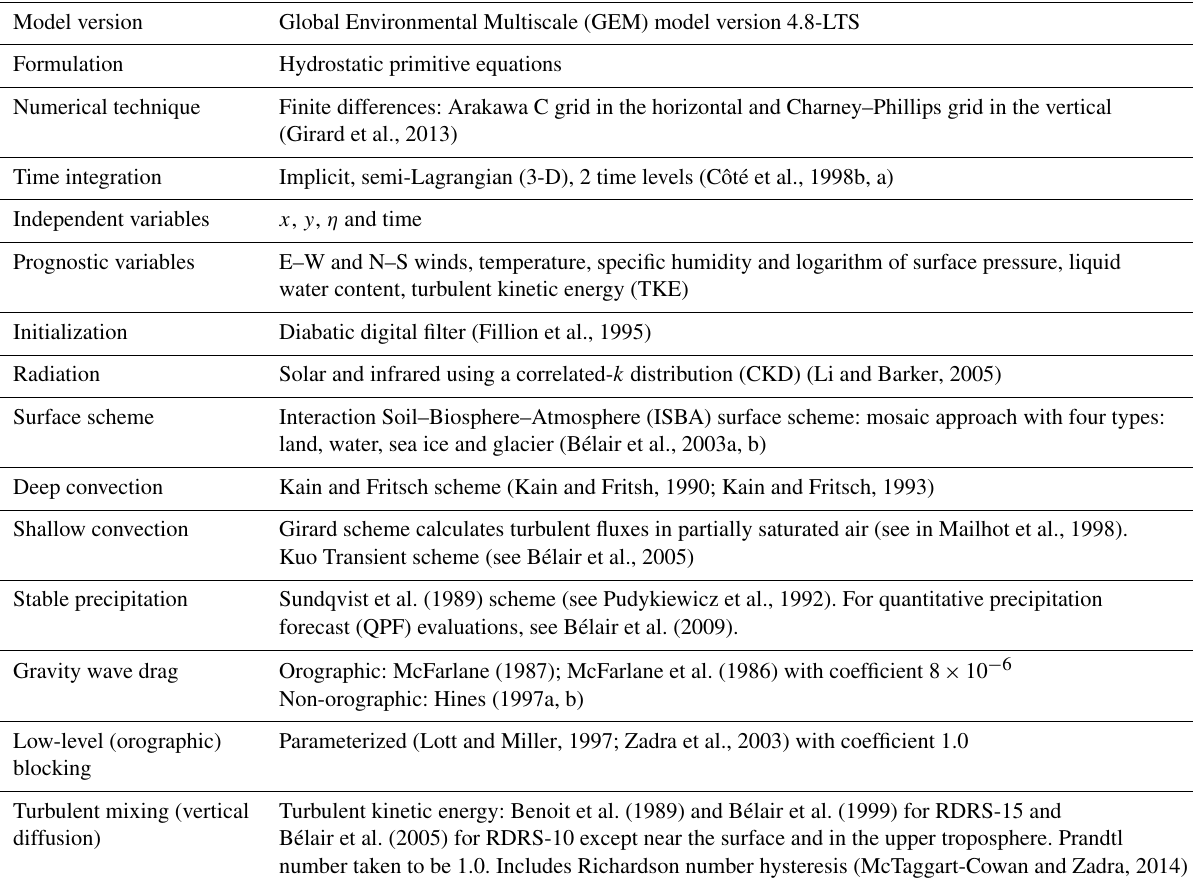
Table 1. Dynamic kernel and physical parameterizations common to the GDRS and RDRS.